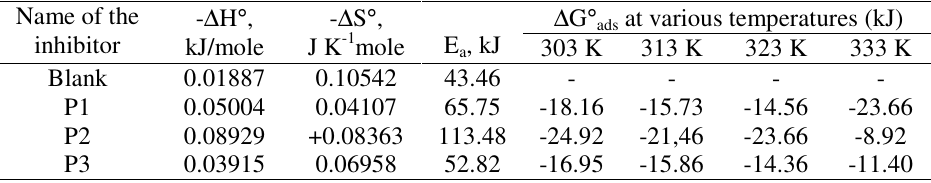
Figure 2. Arrhenius plots of corrosion rate of mild steel in 1 M H presence and absence of inhibitors Table 3. Thermodynamic parameters for mild steel corrosion in 1 M H and absence of inhibitors at 1 mM